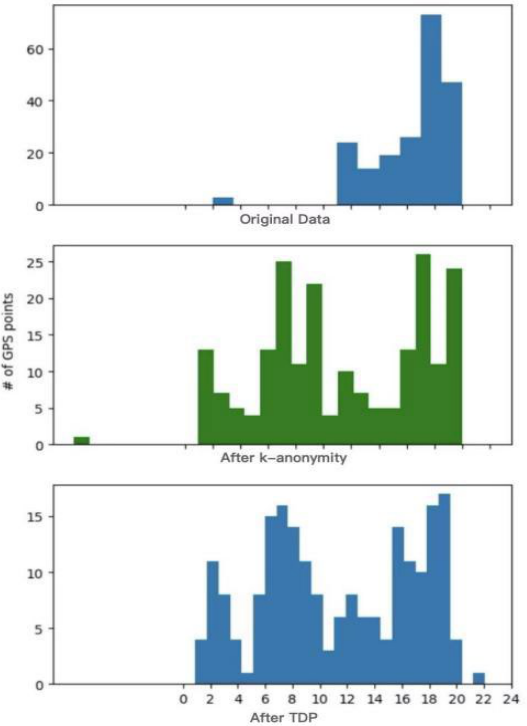
Figure 9. Diagram of time distribution after encrypting data with various algorithms for T-drive Taxi Trajectories dataset.